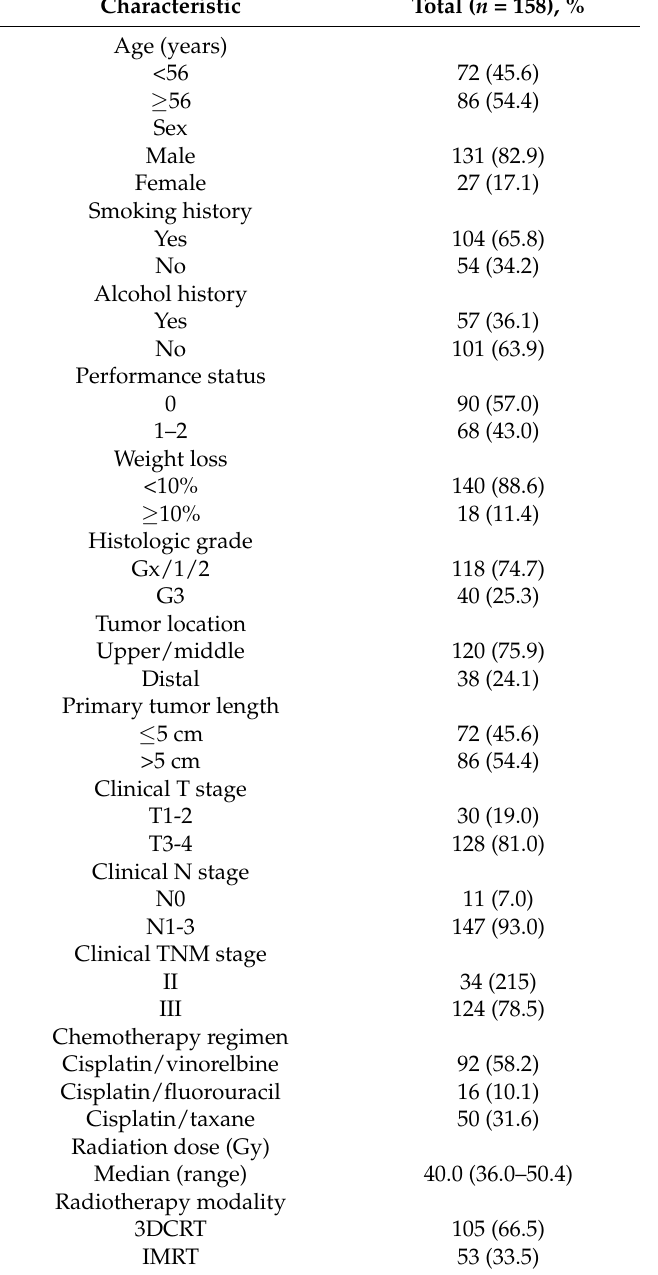
Table 1. Patient